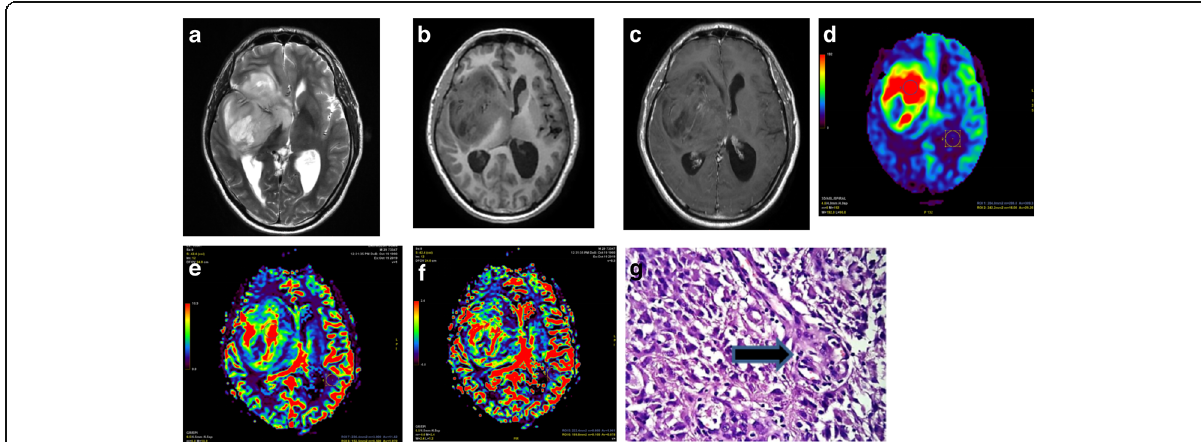
Fig. 3 MR perfusion in a case with the right frontal high-grade glioma. a Axial T2WI showing right frontal hyperintense signal sizable lesion. b , c Pre- and post contrast T1WI showing hypointense signal with patchy faint post contrast enhancement. d ASL-CBF showing a high perfusion of the lesion with ASL-rCBF value of 8.03. e , f DSC-CBF and CBV showing a high perfusion with DSC-rCBF value of 4.16 and DSC-rCBV value of 8.16. g Hematoxylin and eosin staining (×400 magnification) showing increased cellularity with vascular proliferation (arrows), palisading necrosis and marked cellular atypia, pathologically proven glioblastoma, NOS WHO grade IV with ASL matching with DSC in showing hyperperfusion of the lesion. ASL arterial spin labeling, CBF cerebral blood flow, DSC dynamic susceptibility contrast, CBV cerebral blood volume, NOS not otherwise